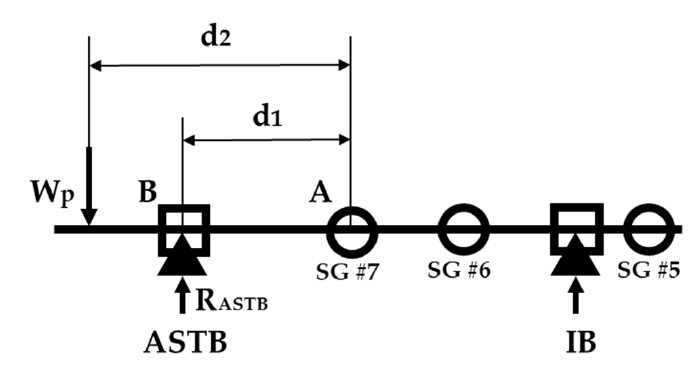
Figure 7. ASTB moment equilibrium equation.